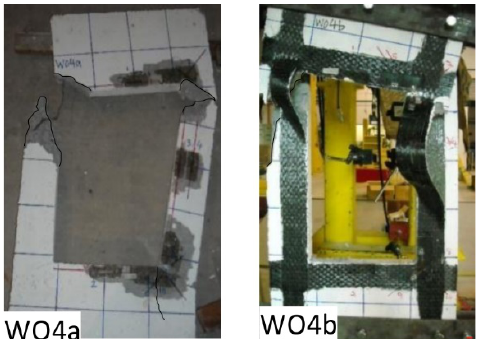
Figure 14. Failure mode in the experimental test. Adapted from Mohammed et al.